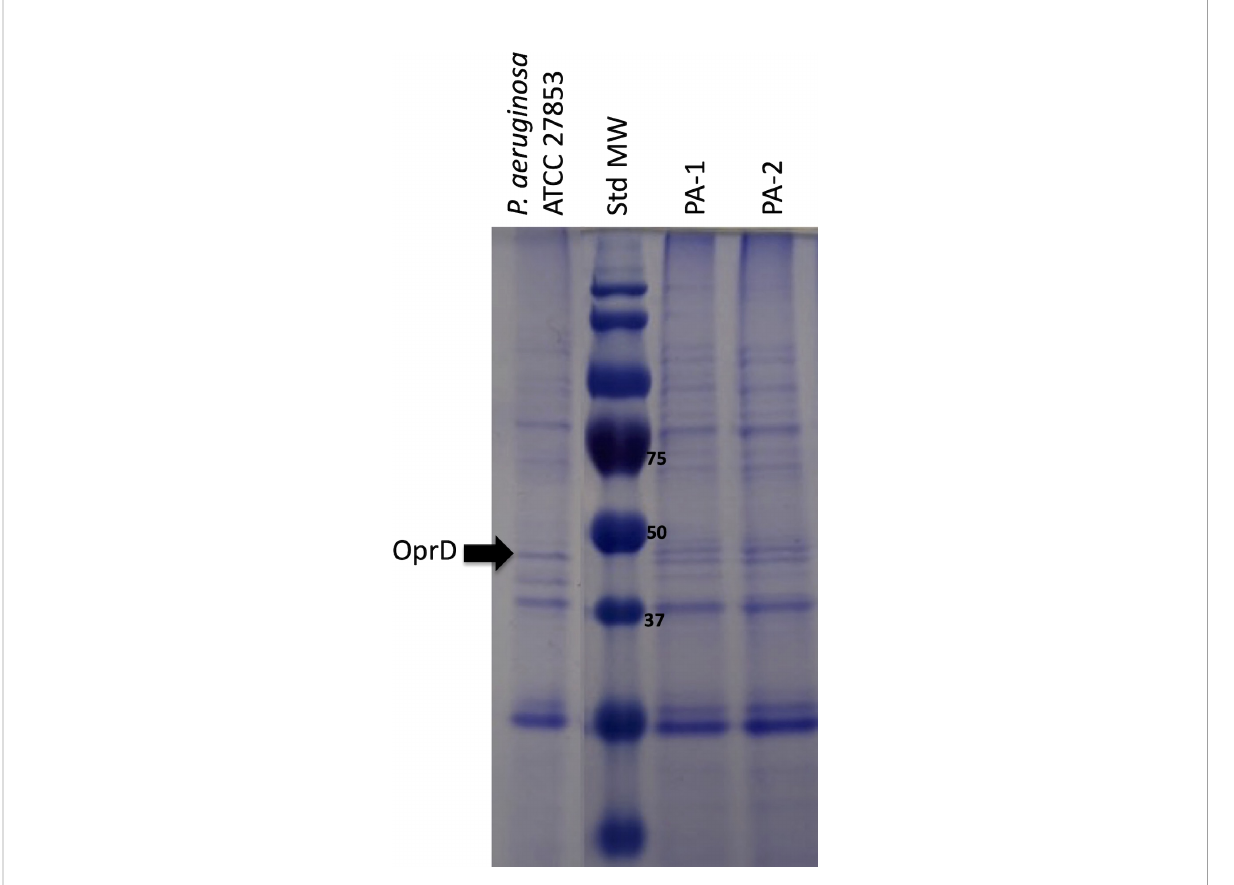
FIGURE 1 SDS-PAGE analysis of outer membrane protein extraction of isolates PA-1 and PA-2. Weight (kDa) of the Molecular Weight Standard (Std MW) bands used in protein electrophoresis is indicated next to the bands. P. aeruginosa ATCC 27853 was used as a control isolate. OprD was located based in its molecular weight of 48,4 kDa and according to previous reports (Rodr ı ́ guez-Beltra ́ n et al.,